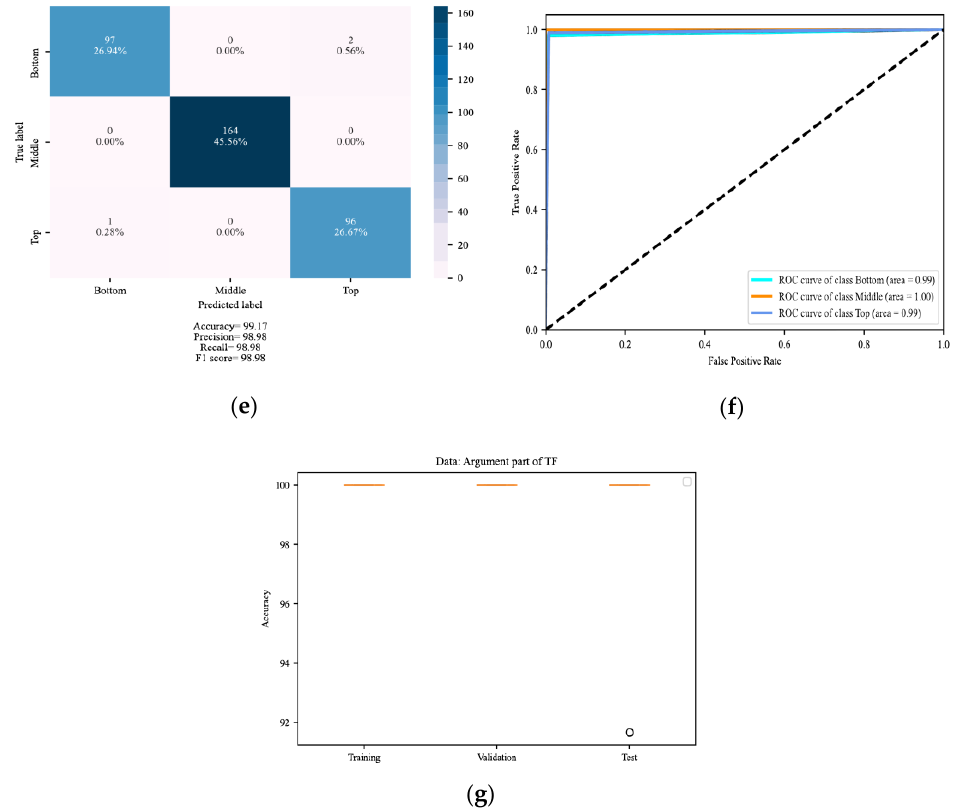
Figure 23. MLP performance in localization of the DSV fault using data of phase part of the TF: ( a ) training confusion matrix; ( b ) training ROC curve; ( c ) validation confusion matrix; ( d ) validation ROC curve; ( e ) test confusion matrix; ( f ) test ROC curve; ( g ) box plot of the training, validation, and test accuracies in thirty iterations.